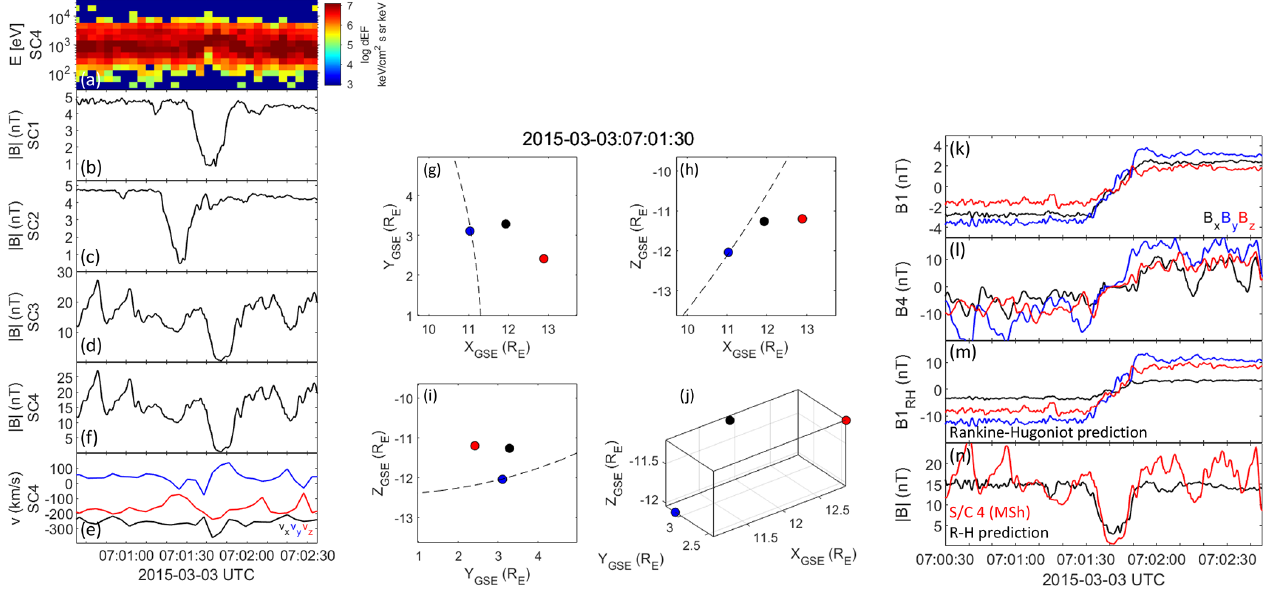
Figure 3. Data in same format as Fig. 2, but for a rotational magnetic hole from 3 March